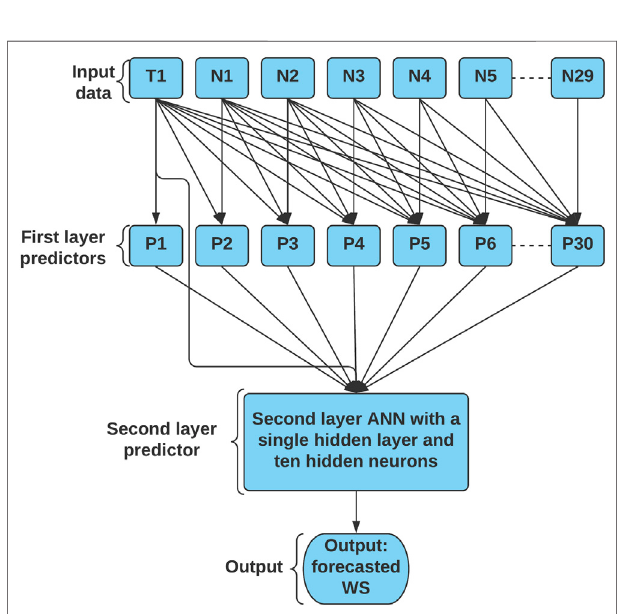
FIGURE 4 | The structure of the proposed MIF-CANN model with input features from one target station and the structure of the proposed MIF-CANN model neighboring